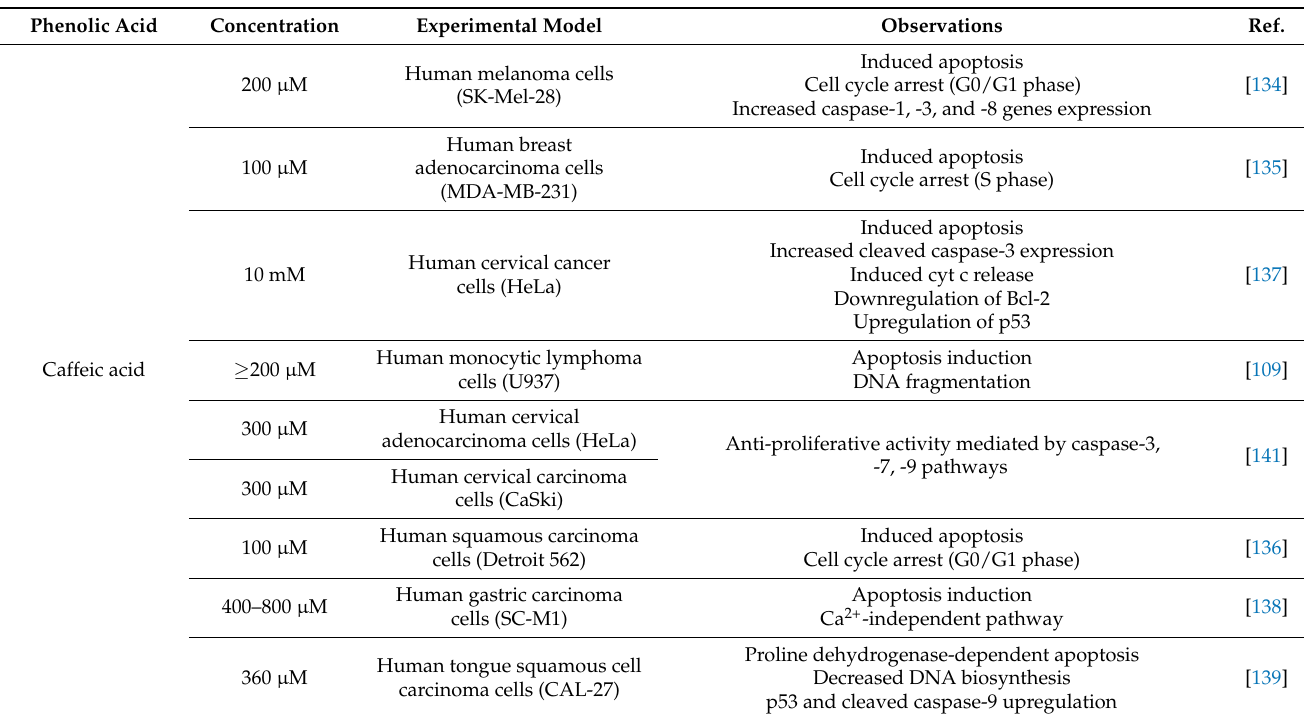
Table 3. Cell death modulation by common phenolic acids from Thymus spp. extracts in in vitro and in vivo animal experimental